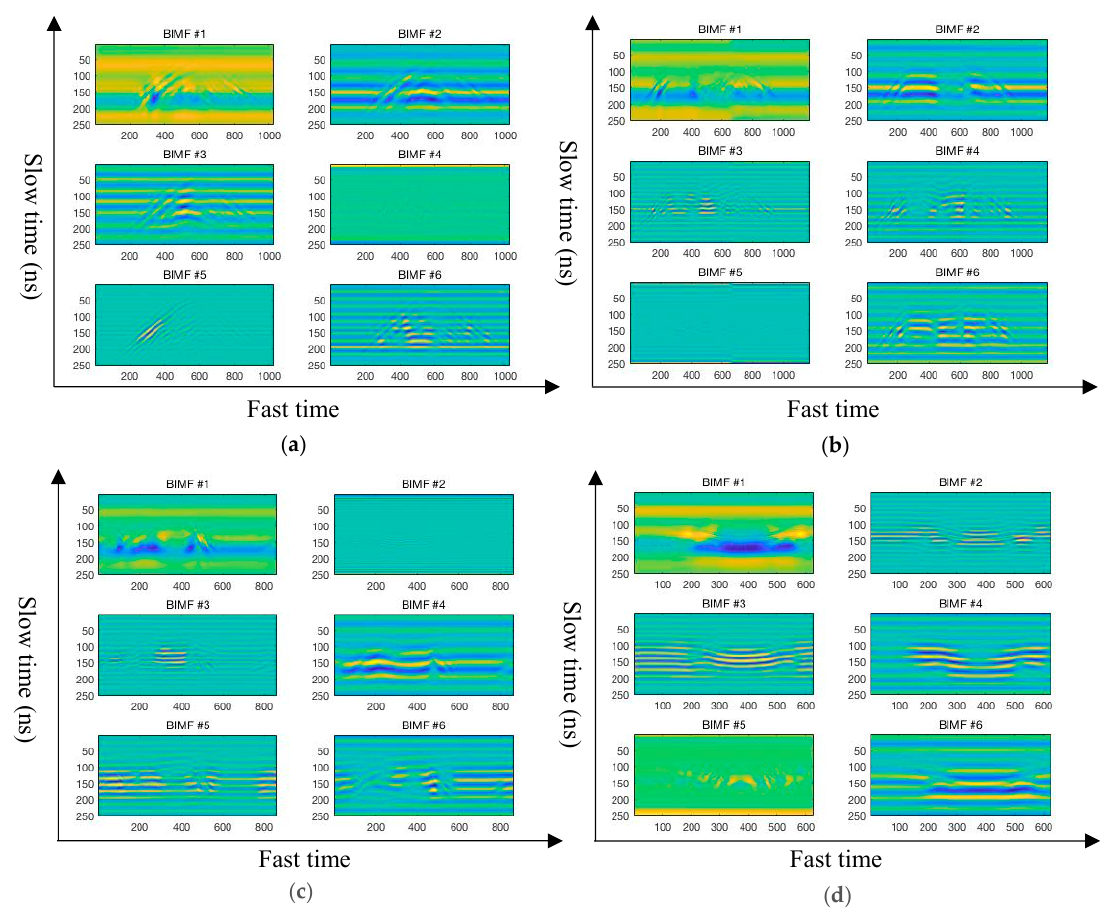
Figure 9. The six BIMF mode components of feature extraction of the carrier-free UWB radar human motion 2D echo analysis signal when the 2D-VMD decomposition layer number is six. ( a ) The six BIMF mode components of feature extraction of walk forward of the carrier-free UWB radar human motion 2D echo analysis signal. ( b ) The six BIMF mode components of feature extraction of fall forward of the carrier-free UWB radar human motion 2D echo analysis signal. ( c ) The six BIMF mode components of feature extraction of walk around of the carrier-free UWB radar human motion 2D echo analysis signal. ( d ) The six BIMF mode components of feature extraction of the carrier-free UWB radar human motion 2D echo analysis signal.